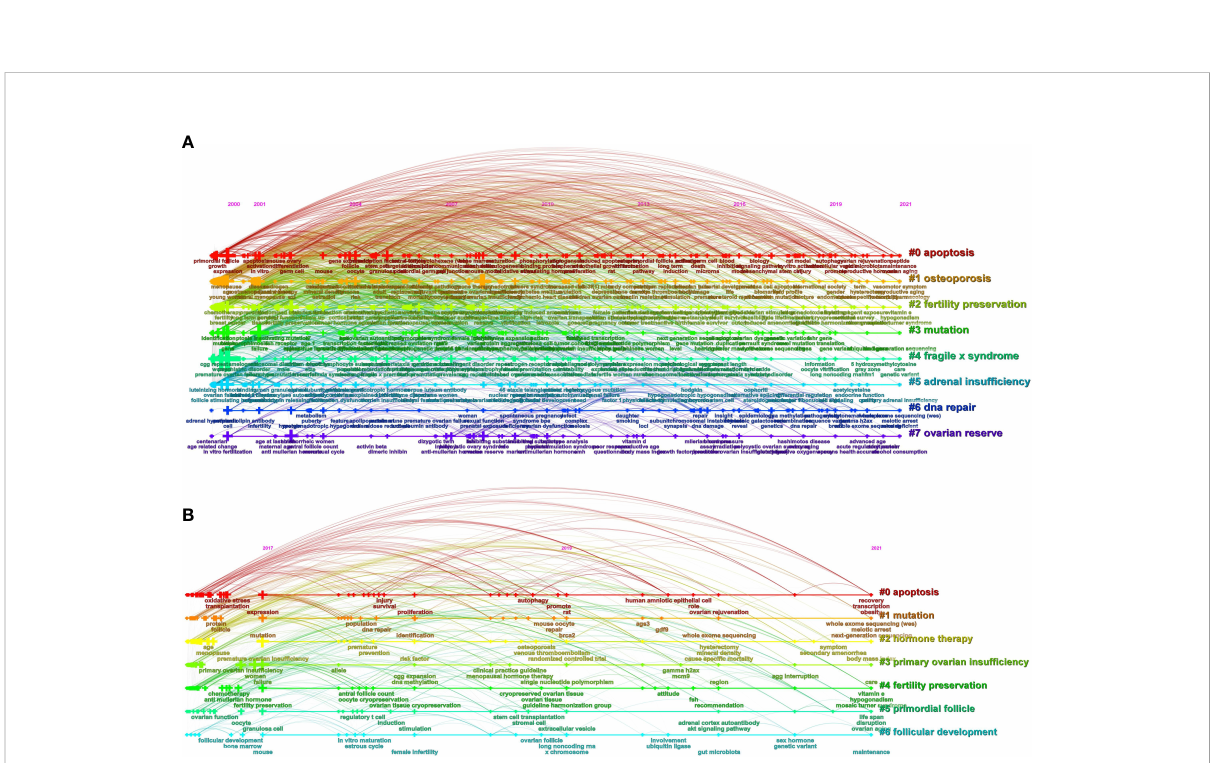
FIGURE 4 The publishing performance of keywords. (A) Timeline view of keyword clusters on POI research from 2000 to 2021. (B) Timeline view of keyword clusters on POI research in the past 5 years. The horizontal line shows the clusters. The crosses on the horizontal line represent the keywords contained in the corresponding cluster, and their size represents the frequency of keywords. The curved line represents the relationships between the clusters. The cluster labels are on the right.